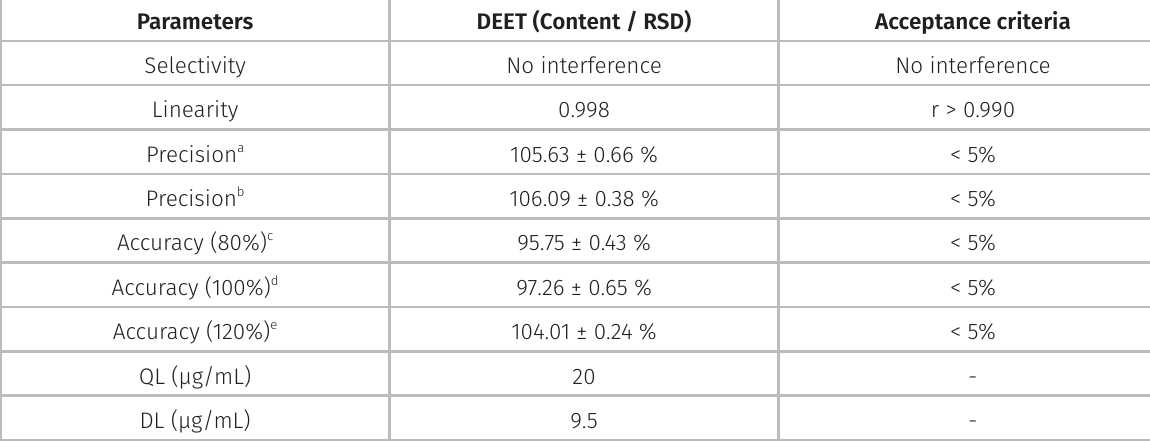
Table IV. Results of the validation of the analytical